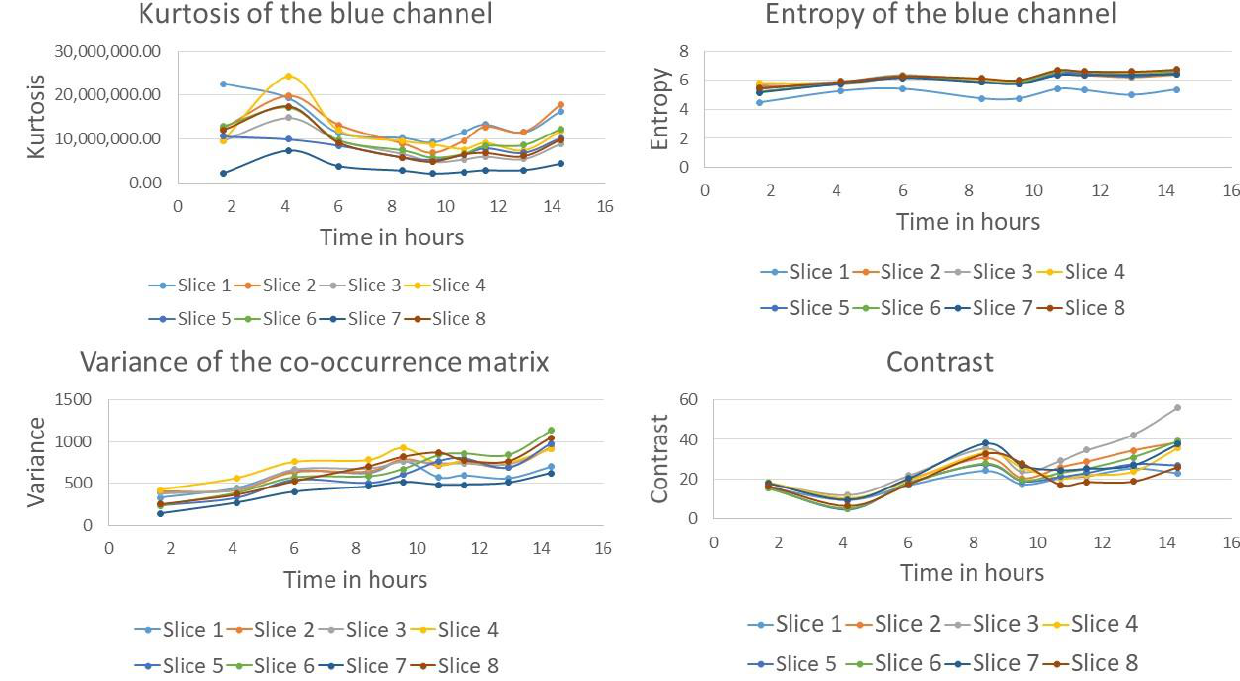
Figure 9. Drying curves for other visual features.